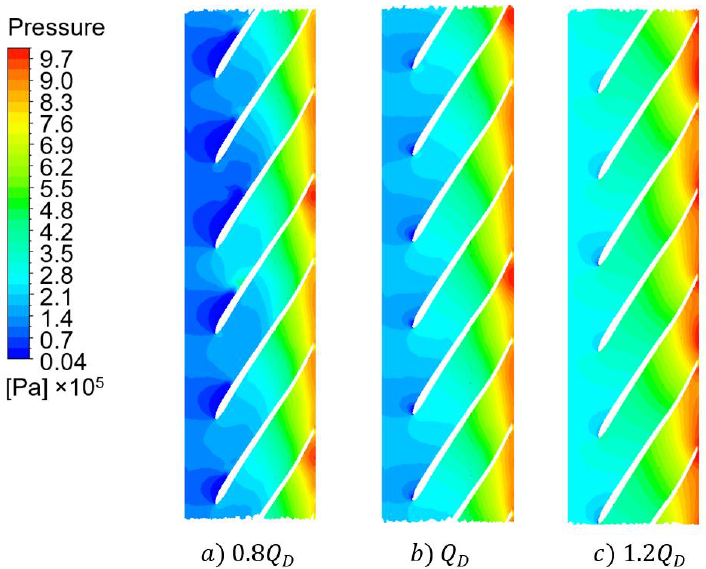
Figure 12. Pressure contour plots on blade-to-blade surface taken at midspan at various flow rates: